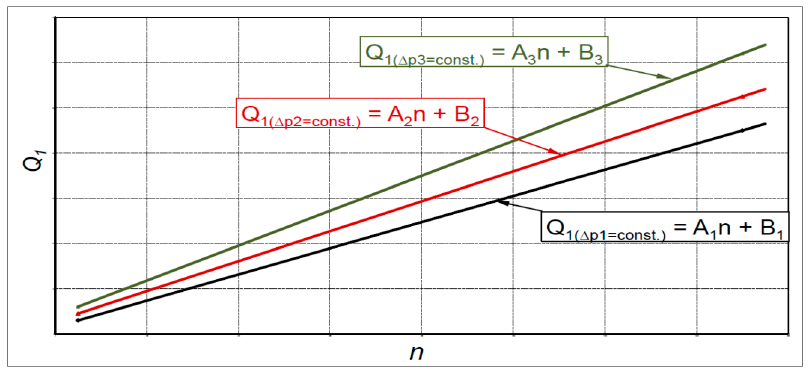
Figure 2. Linear interrelationship between motor input flow rate Q 1 and shaft speed n [6].